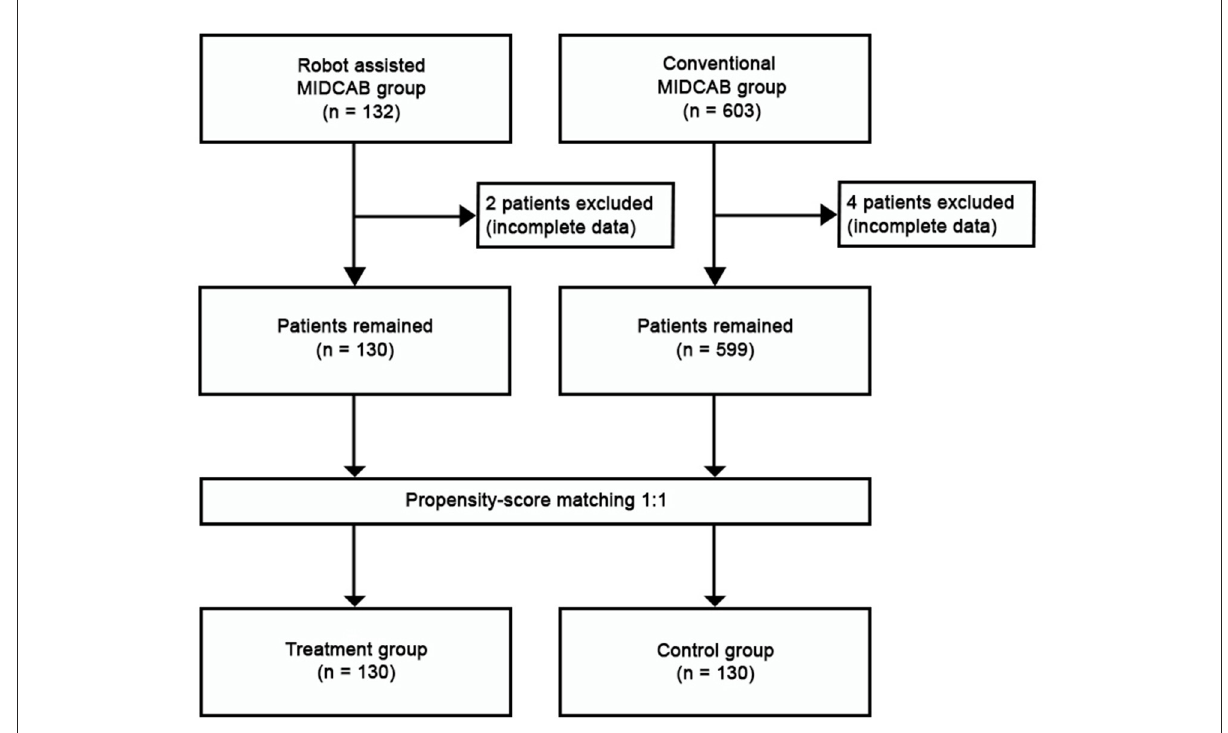
FIGURE1 Study flowchart. MIDCAB, minimally invasive direct coronary artery bypass grafting.